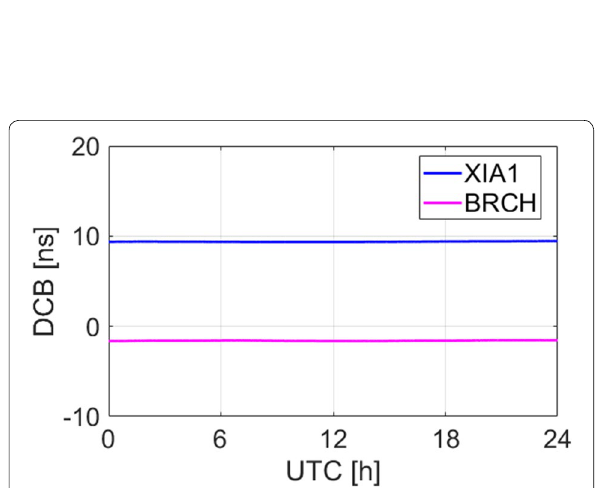
Fig. 8 Time series of DCB in QF4 PPP model at iGMAS stations XIA1